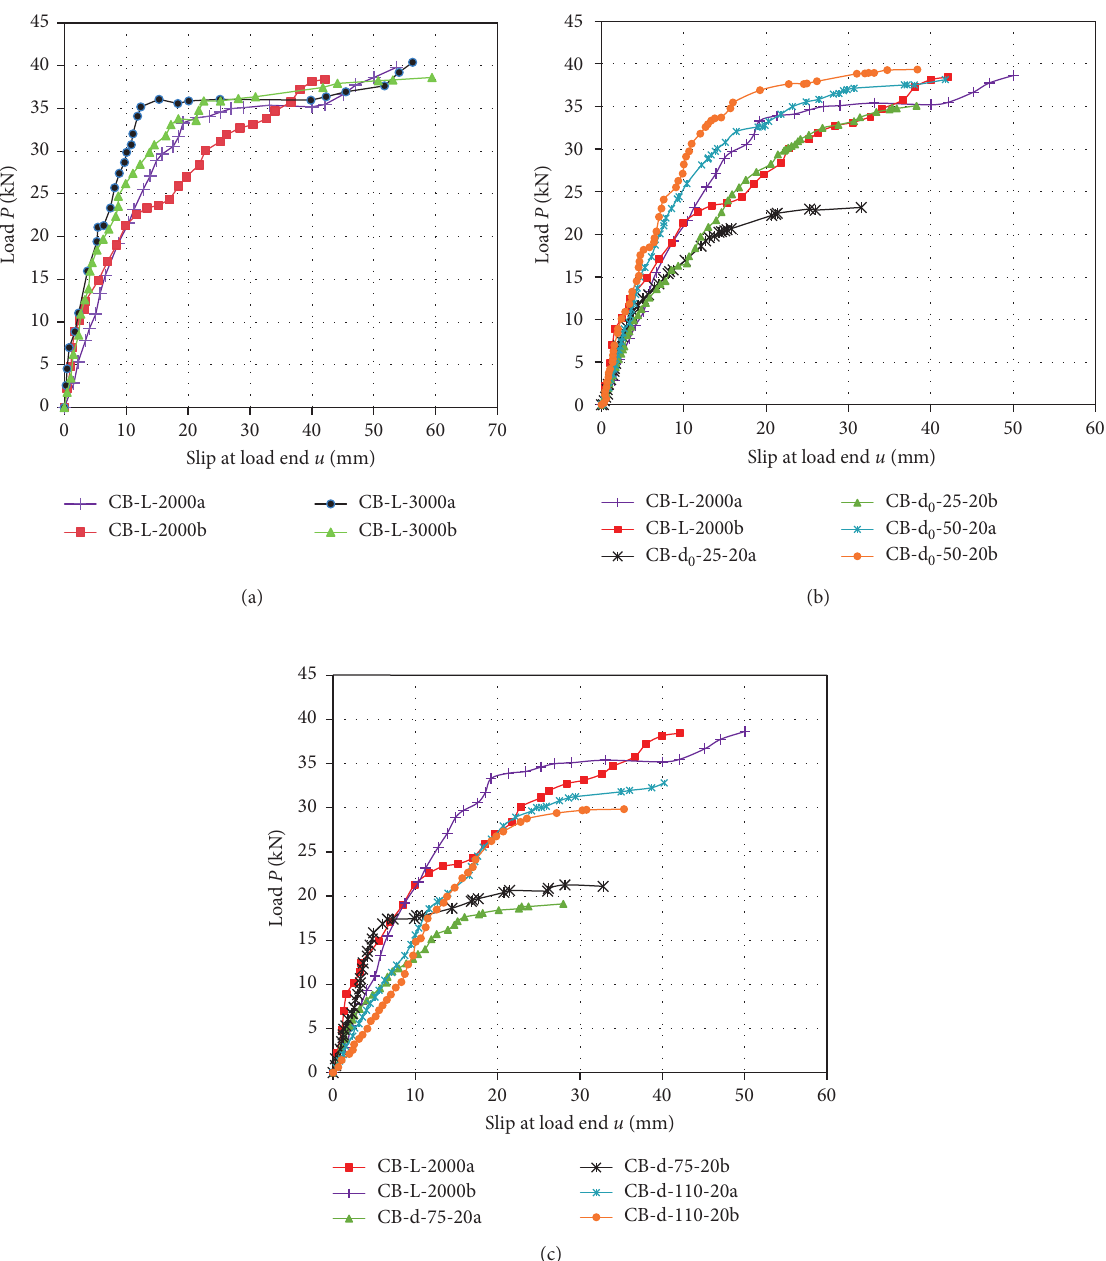
Figure 13: Load-displacement curve of long bolt specimens ( L ≥ L bolt hole